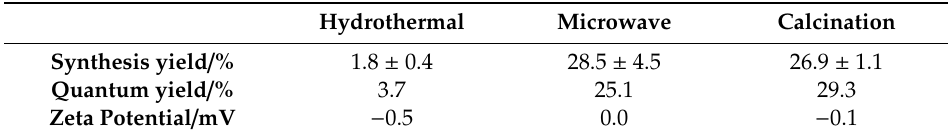
Table 1. Synthesis and fluorescence quantum yields (in %) and zeta potential (in mV) data for the three CDs.